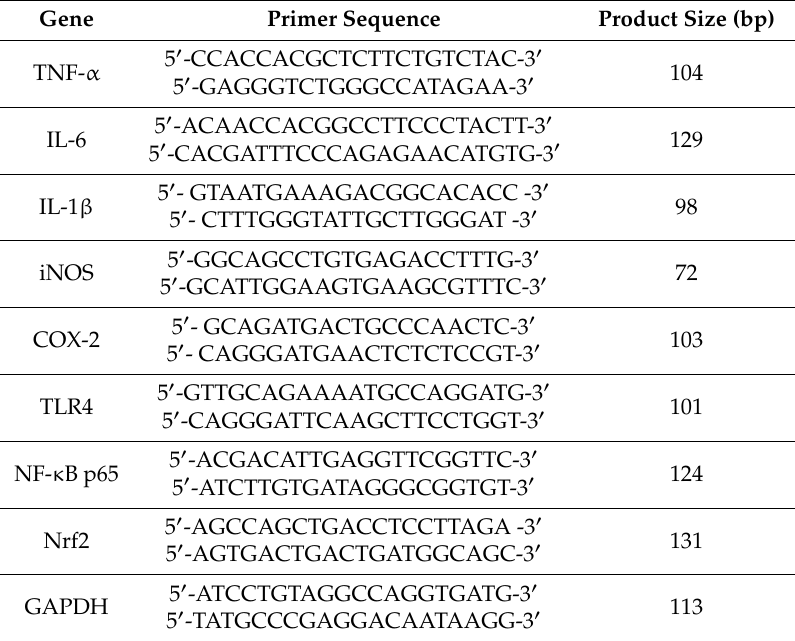
Table 1. Primers used for